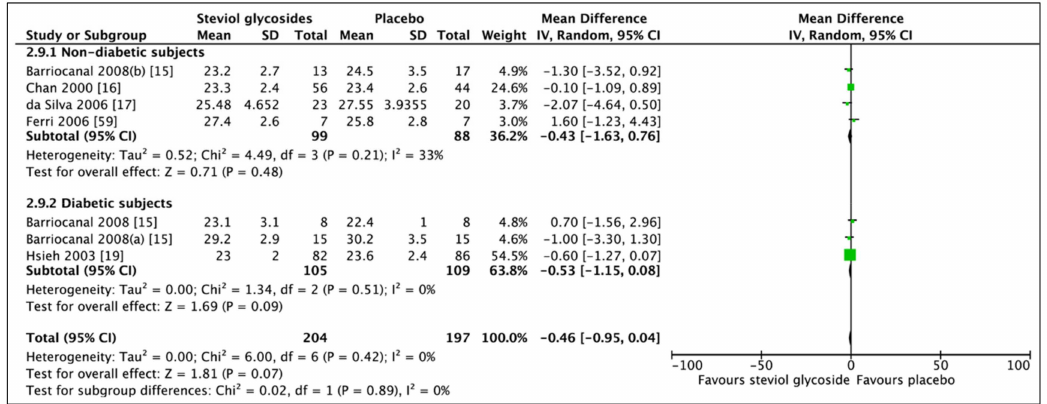
Figure 3. Risk of bias summary of studies included in meta-analysis examining the e ff ect of SGs on human health. Adequate reporting is marked by either green (no bias) or red (bias). Nonadequate information about the bias in question is marked by “?”.